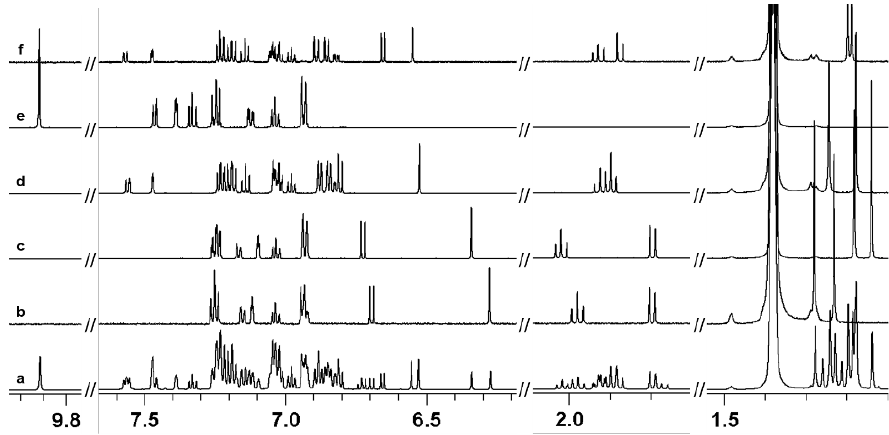
Figure 5. 1 H NMR (600 MHz, C 6 D 12 , 300 K) spectra of ( a ) stressed sample and compounds isolated from fraction collection: ( b ) i -DLM, ( c ) a -DLM, ( d ) S / R -PBDM, ( e ) 3-PBA, and ( f ) R / S -PBDM.